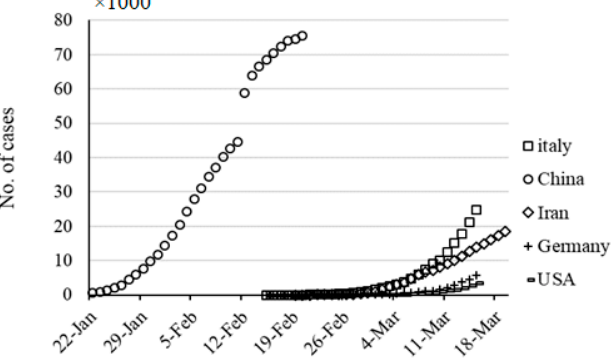
Figure 2. Cumulative number of cases for five countries during a thirty-day period.